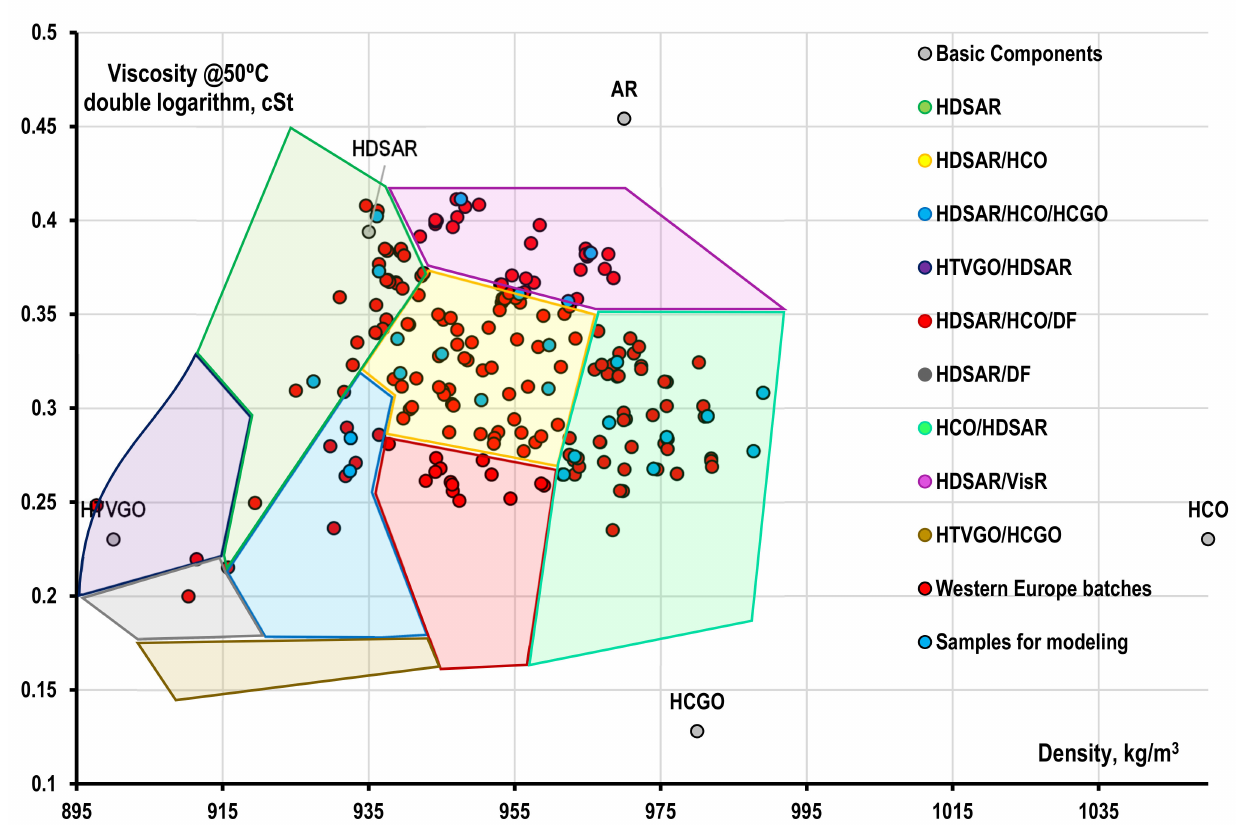
Figure 22. Lots of Western European ports in logarithmic coordinates (standard typing) [89]. In order to reduce the amount of work, 24 samples were selected for modeling, dis- tributed over the entire viscosity–density characteristic of European batches. The results of modeling their composition are presented in Table